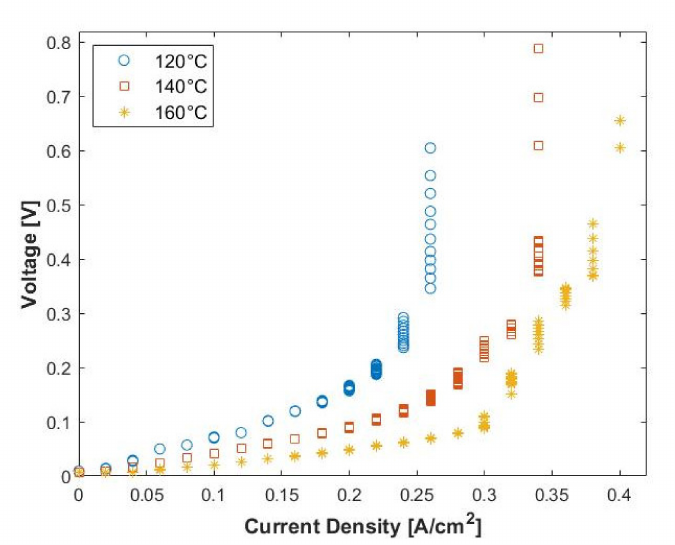
Figure 4. Polarization curve for pure hydrogen (100 mL n /min, 1 atm).